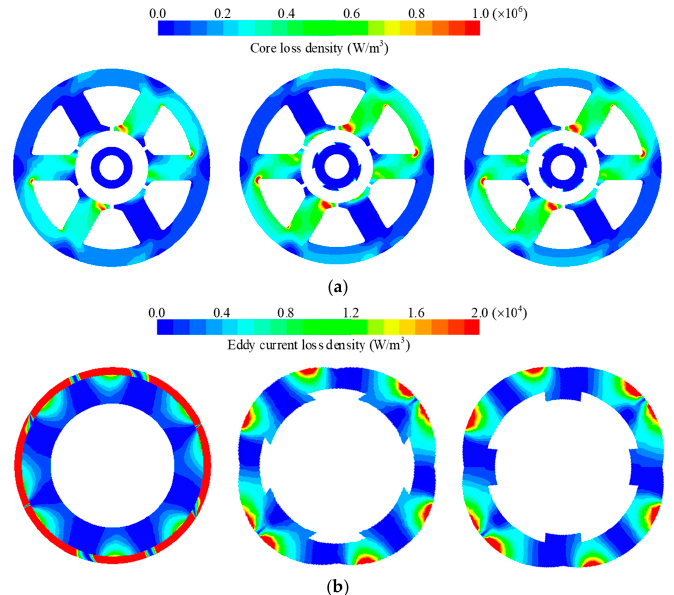
Figure 13. Distribution of loss density. ( a ) Core loss density. ( b ) Eddy current loss density.